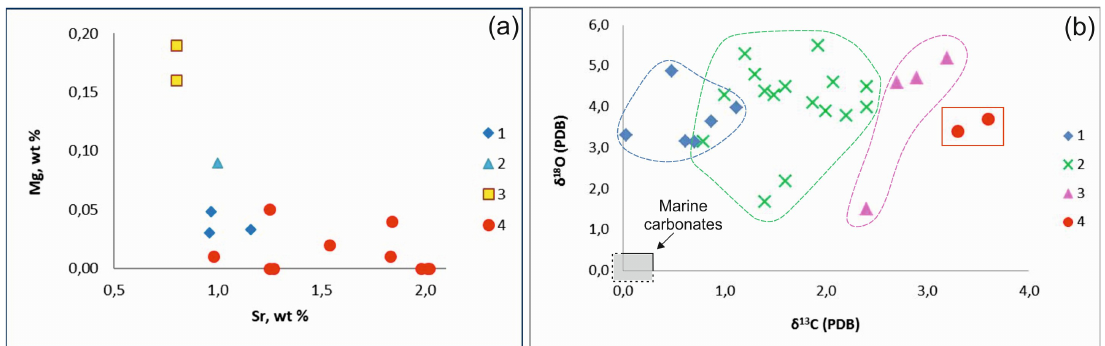
Figure 15. ( a ) Mg and Sr content of aragonite from sulphide breccia from Semyenov-2 hydrothermal field (4), compared with Mg and Sr concentration in aragonite from deep sea serpentinized ultramafic rock by Bonatti, 1980 (1) [32], and Thompson, 1970 (2) [33] and coral by Thompson, 1970 (3) [33]; ( b ) plot of δ 18 O versus δ 13 C values of (1) aragonite from deep sea serpentinized ultramafic rock [32], (2) carbonate chimneys of Lost City and Lost Village [35–37], (3) carbonate in-filling in fractured serpentine from Lost City [35], (4) aragonite from sulphide breccia of Semyenov-2 hydrothermal field (this